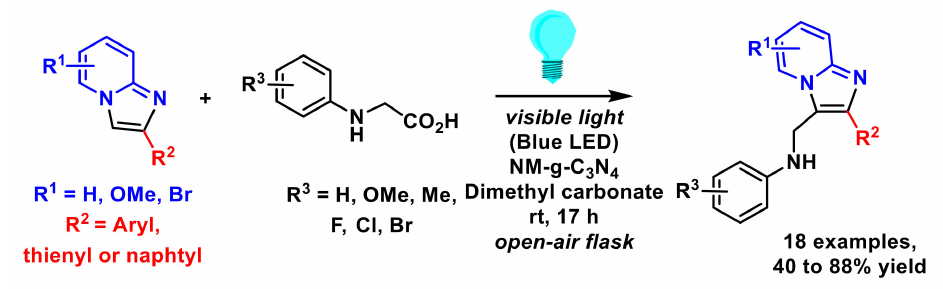
Zhu and Le monitored the C–H aminomethylation reaction with N -arylglycine deriva- tives in an analogous eco-compatible way [52]. The reaction occurred efficiently under photocatalyst-free conditions (Scheme 17). A wide range of functionalized imidazopy- ridines was provided with good results (40 to 95% yields). The group unraveled the aminomethylation path with various control experiments, namely, reaction under a nitro- gen atmosphere or in an open-air flask, or radical trapping with TEMPO. By blue-LED irradiation, a singlet oxygen could be formed and interact with the N -arylglycine substrate to generate a radical cation. This latter intermediate could evolve in an alkyl radical by proton transfer and decarboxylation. Subsequently, the amino radical could undergo a proton transfer, leading to the corresponding imine. The final electrophilic addition of the imine to the imidazopyridine motif allows access to the target